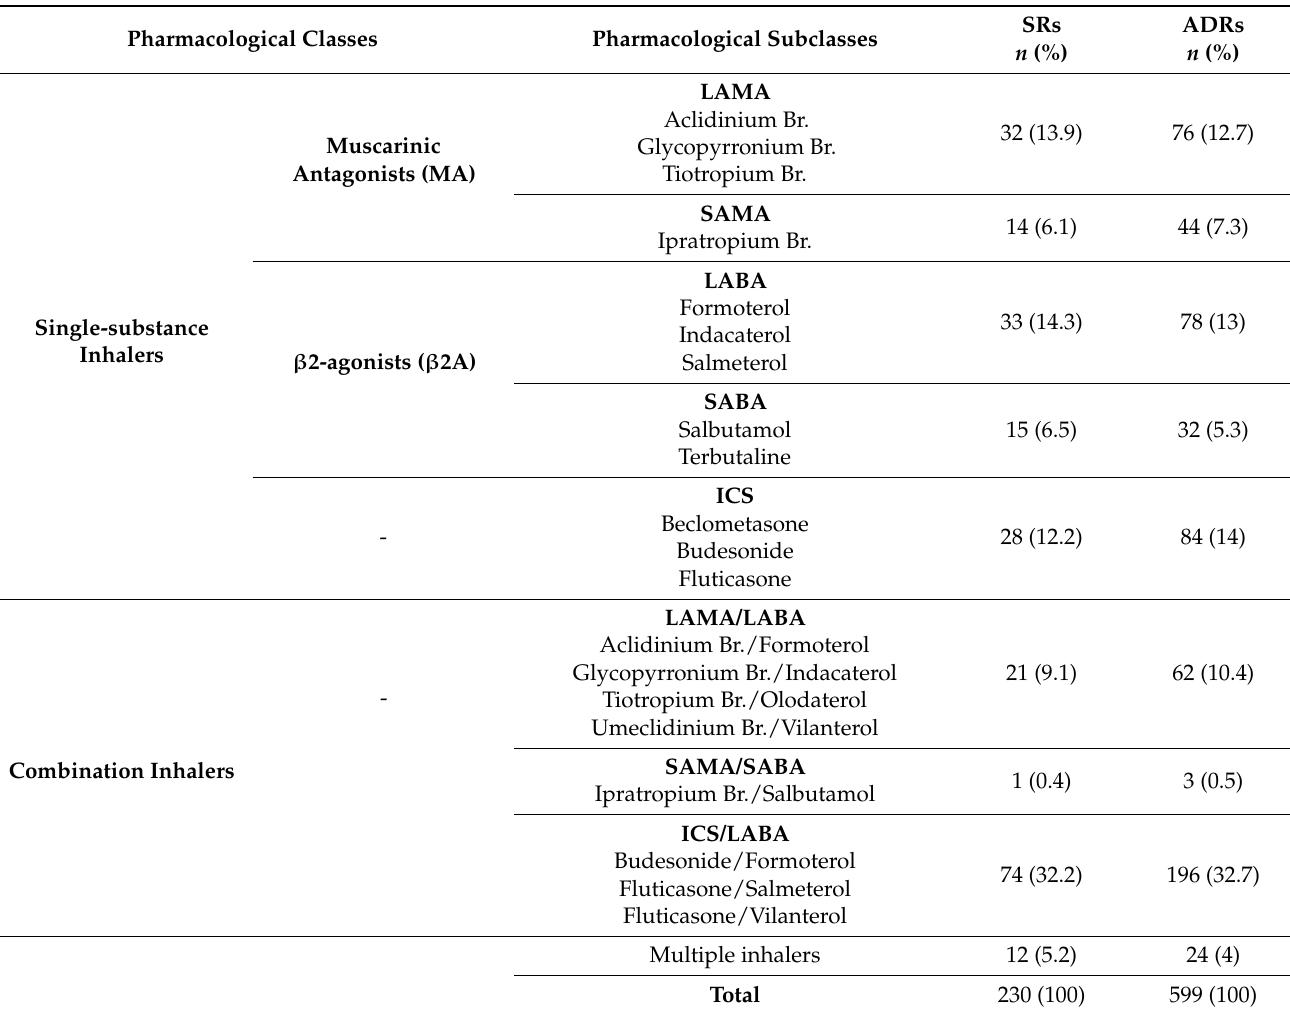
Table 3. Frequency of Spontaneous Reports (SRs) and suspected Adverse Drug Reactions (ADRs) by pharmacological class. Pharmacological Classes